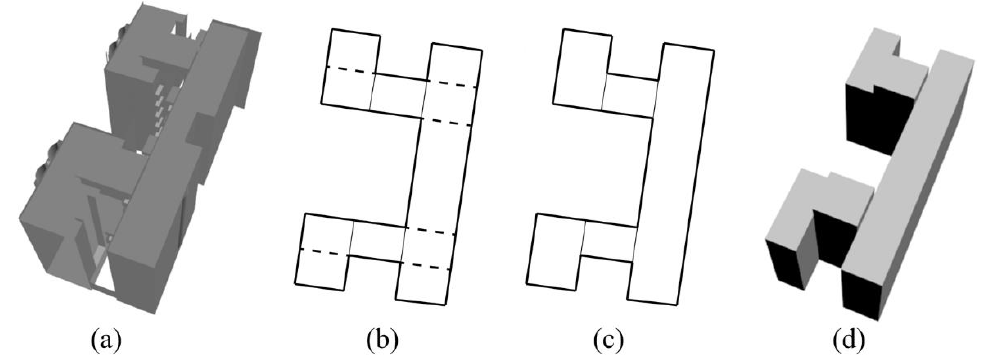
Figure 6. The extraction of representative edges from a 3D building owning multiple roof heights: ( a ) the original 3D building; ( b ) the extracted edges (representative edges: solid regular lines and solid thin lines; normal edges: dashed lines); ( c ) the representative edges; and ( d ) the reconstructed watertight 3D building.